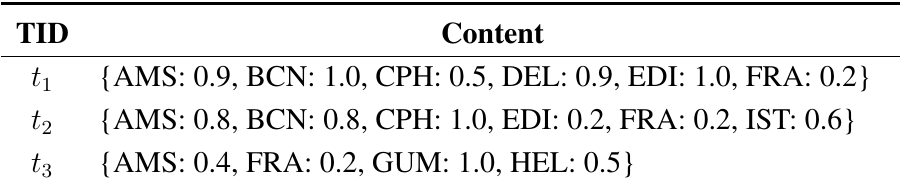
Table 1. An illustrative sample set of uncertain big data.